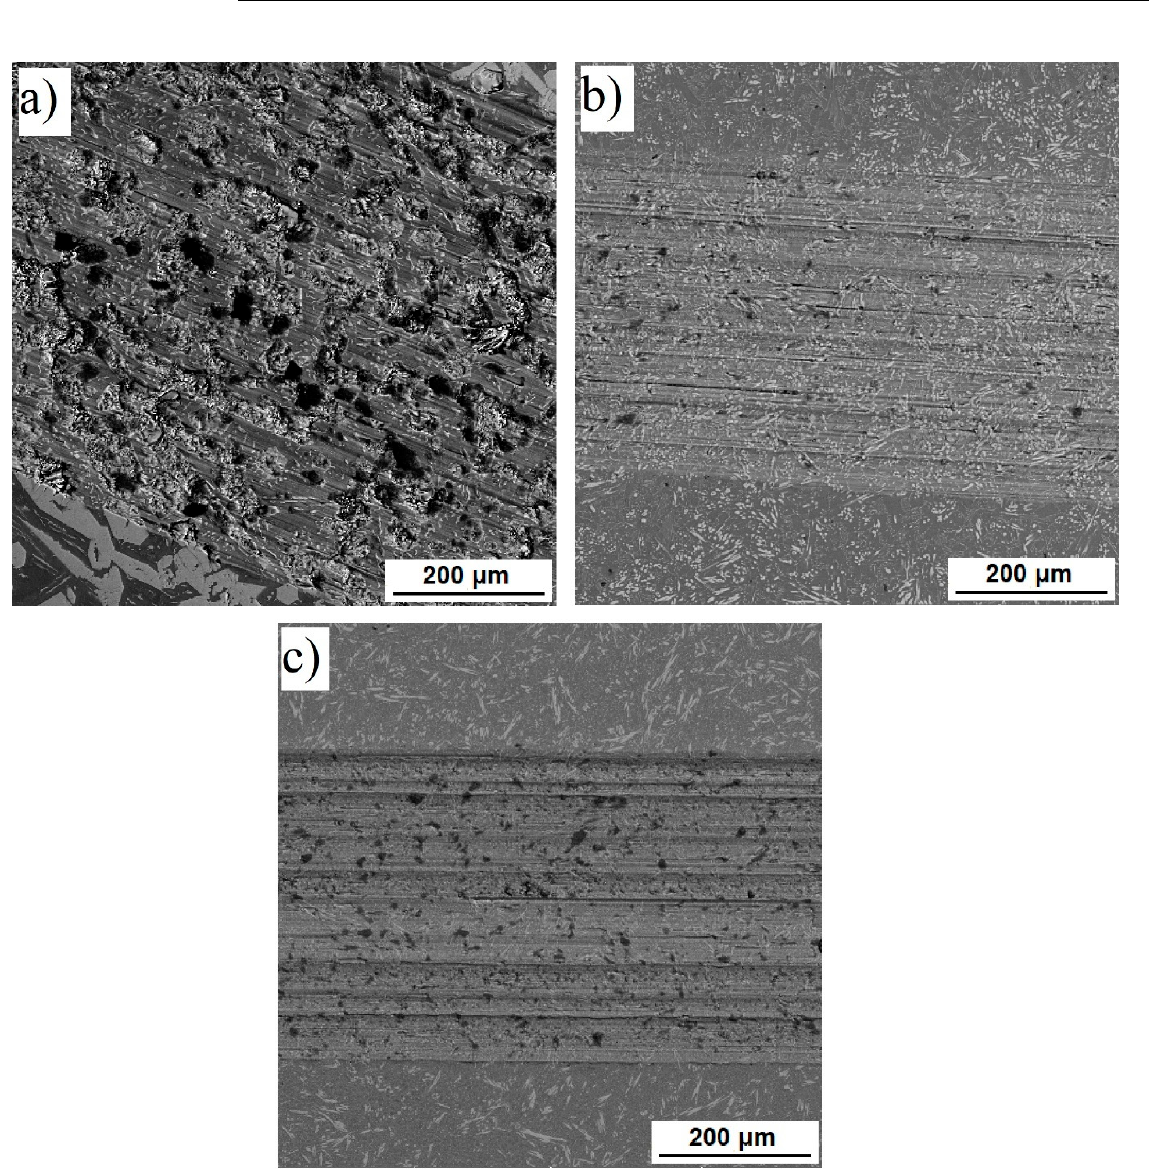
Figure 3. Morphology of the wear tracks (SEM-BSE) on: ( a ) TiAl15Si15 in as-cast state, ( b ) TiAl35Si5 in as-cast state, ( c ) TiAl35Si5 after HIP.